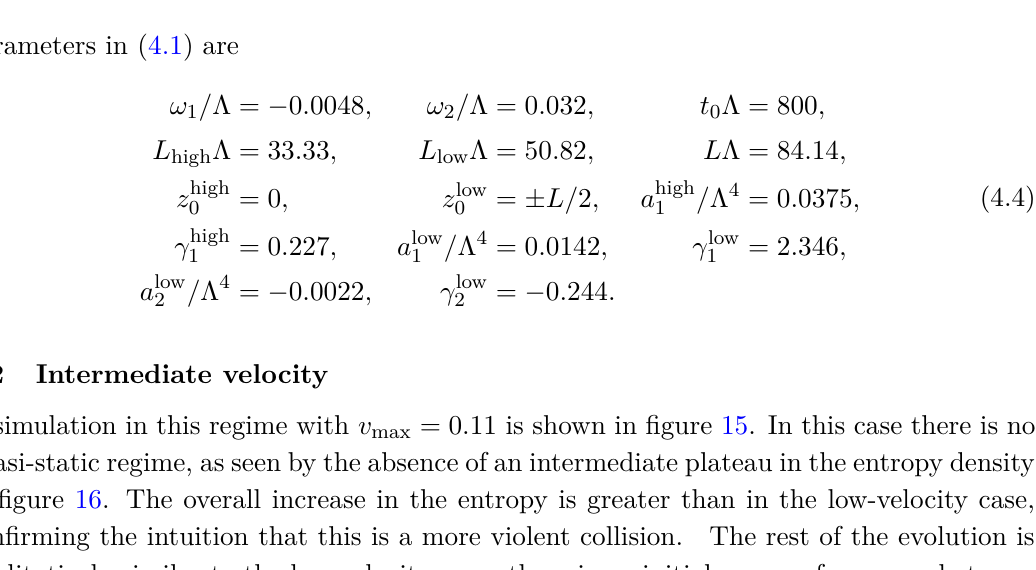
Figure 14 . Oscillations of the high- and low-energy phases during the relaxation period after the